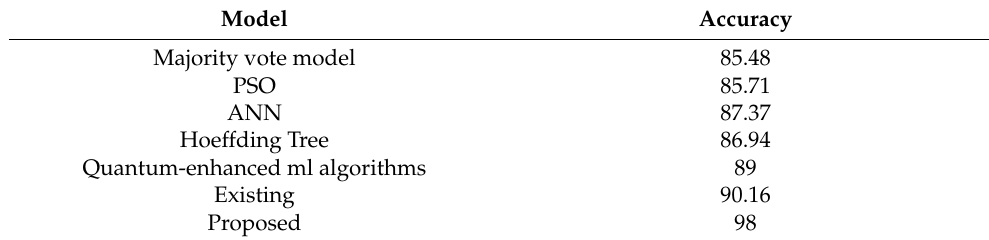
Table 10. Comparative Evaluation [62].